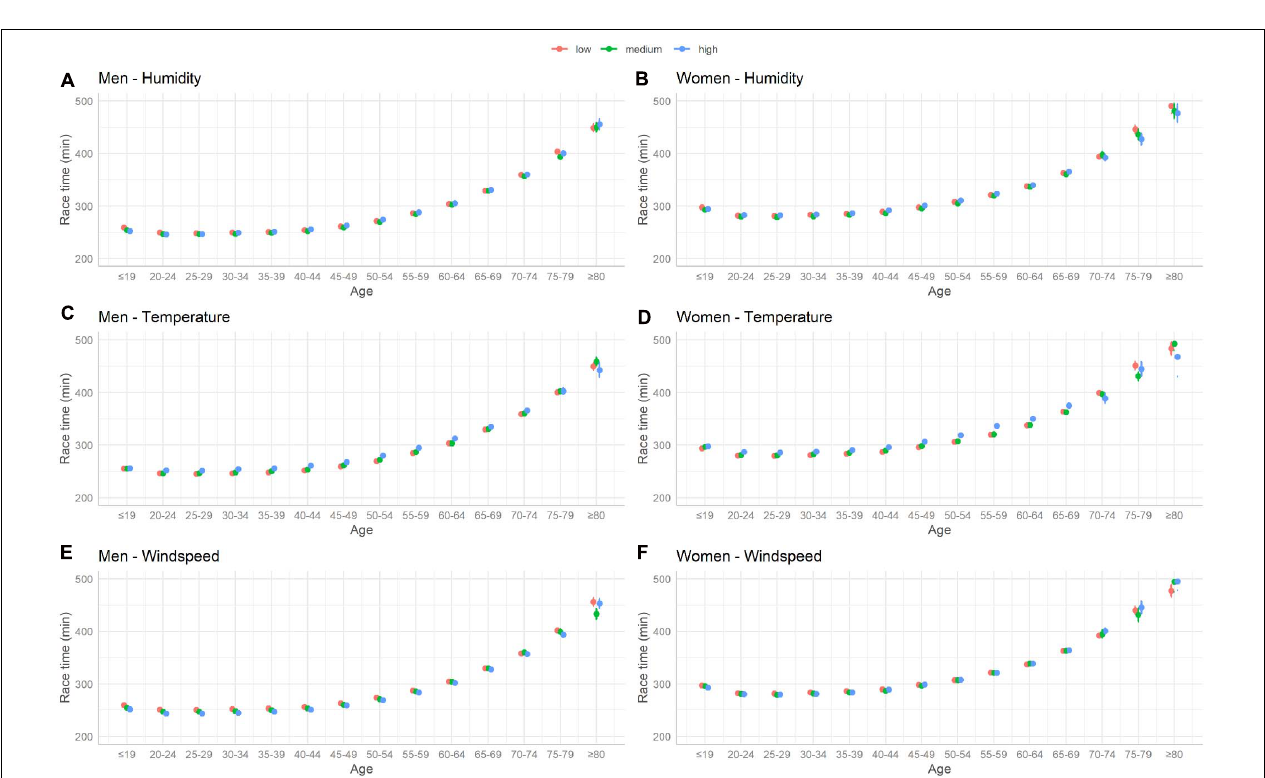
FIGURE 6 | Predicted average race time (min) with 95% confidence intervals for each age group and weather category derived from the linear mixed models. Humidity for men (A) and women (B) , temperature for men (C) and women (D) , wind speed for men (E) and women (F)